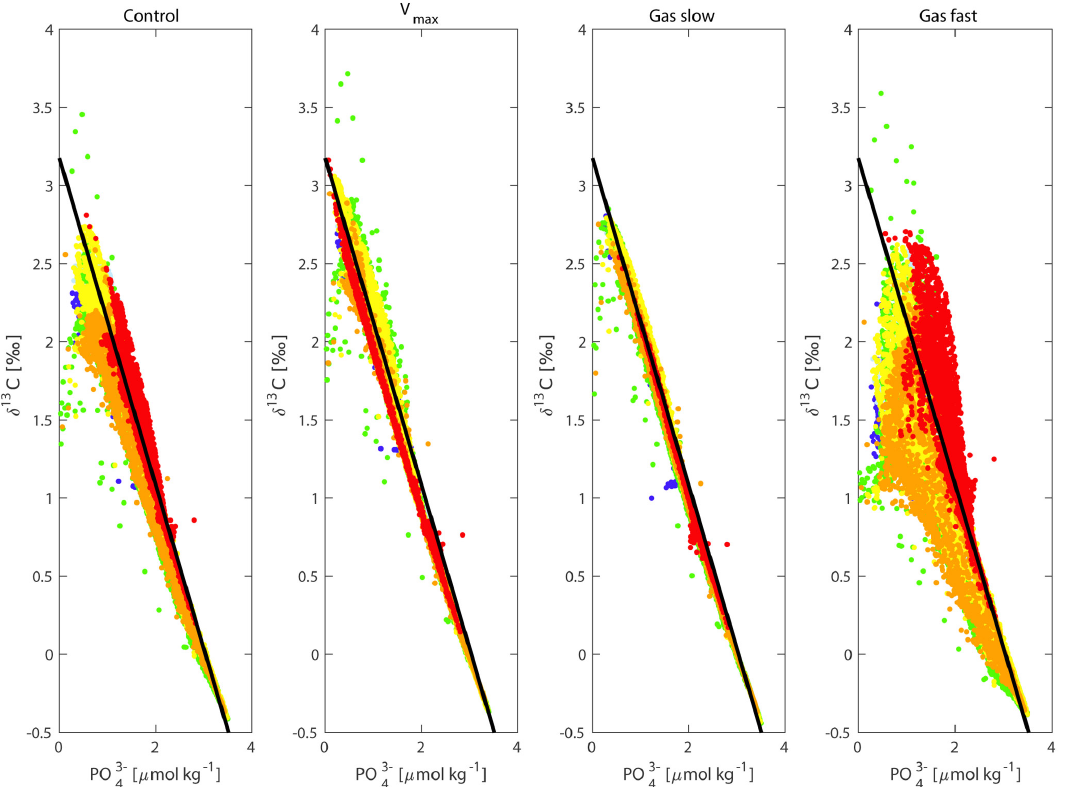
Figure 8. δ 13 C versus PO 3 − for the control, V max , “gas slow” and “gas fast” experiments for all ocean basins except the Nordic Seas (i.e. 4 basins A to F in Fig. S8). Dark blue = A/North Atlantic, Light blue = B/South Atlantic, Red = C/Southern Ocean, Yellow = D/South Pacific, Green = E/North Pacific, Orange = F/Indian Ocean. The black line is the δ 13 C bio = 3 . 18 − 1 . 05 × PO 3 − between δ 13 C and PO 3 − expected if only biology affected δ 13 C (Sect. 2). Deviations from the black line represent the relative importance 4 of air–sea gas exchange compared to biology for δ 13